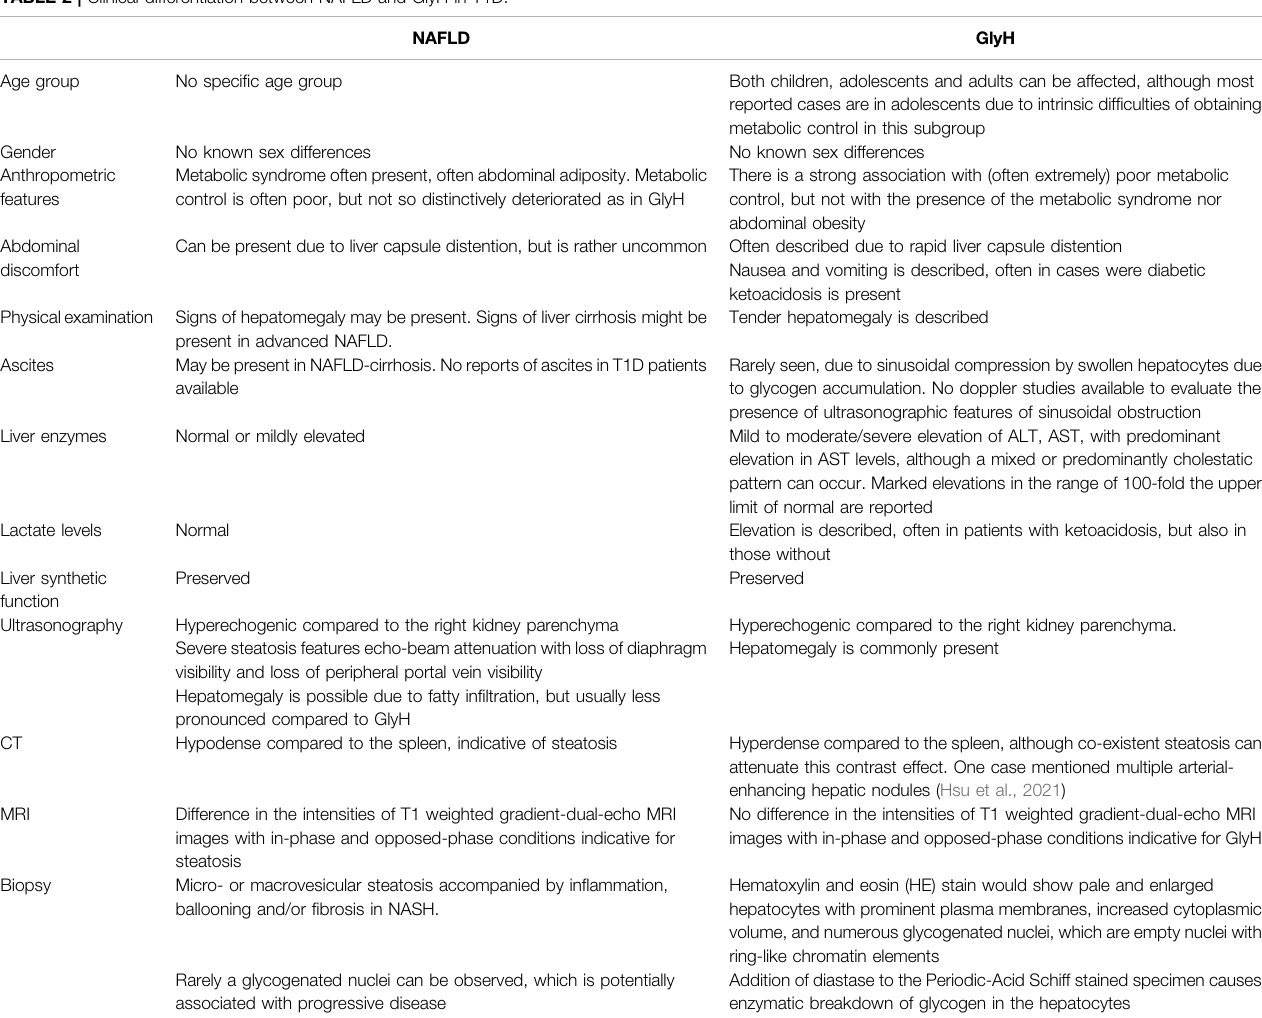
TABLE 2 | Clinical differentiation between NAFLD and GlyH in